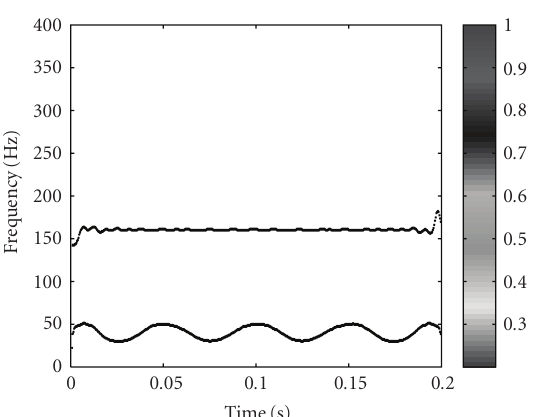
Figure 4: The multicomponent signal.